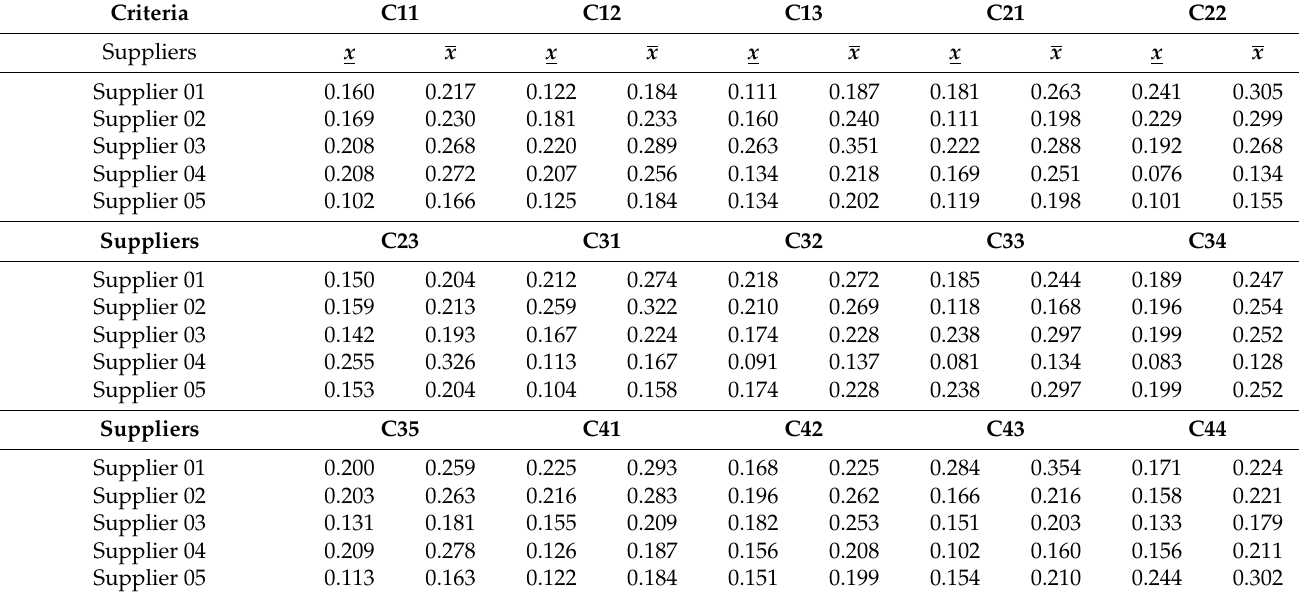
Table A2. The normalized grey decision matrix of G-COPRAS.